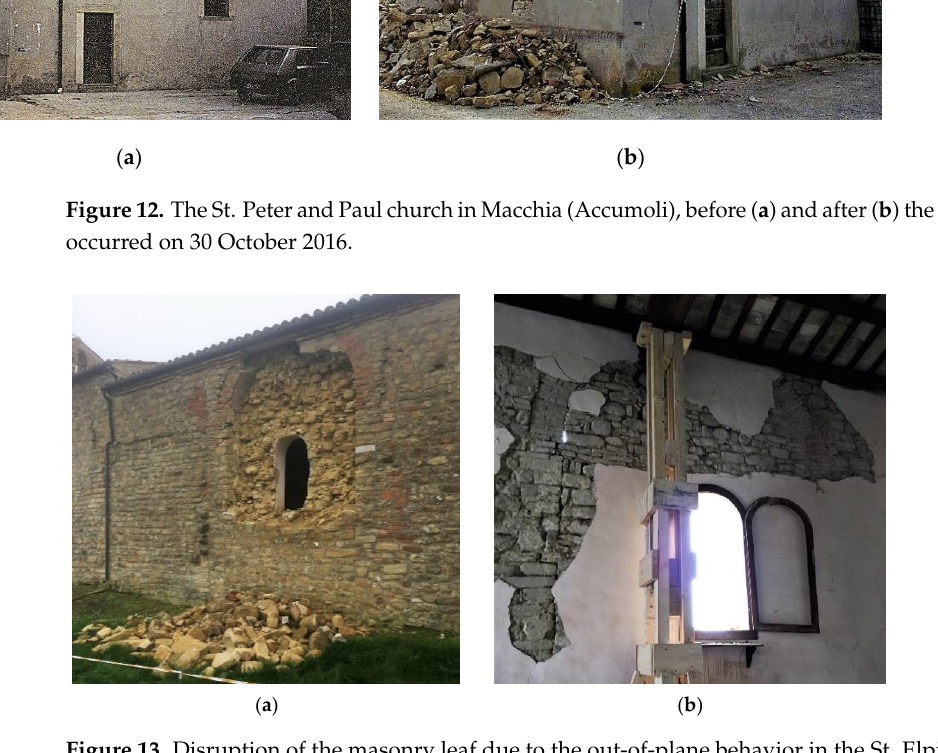
Figure 13. Disruption of the masonry leaf due to the out-of-plane behavior in the St. Elpidio church in Gualdo, Macerata: ( a ) external and ( b ) internal